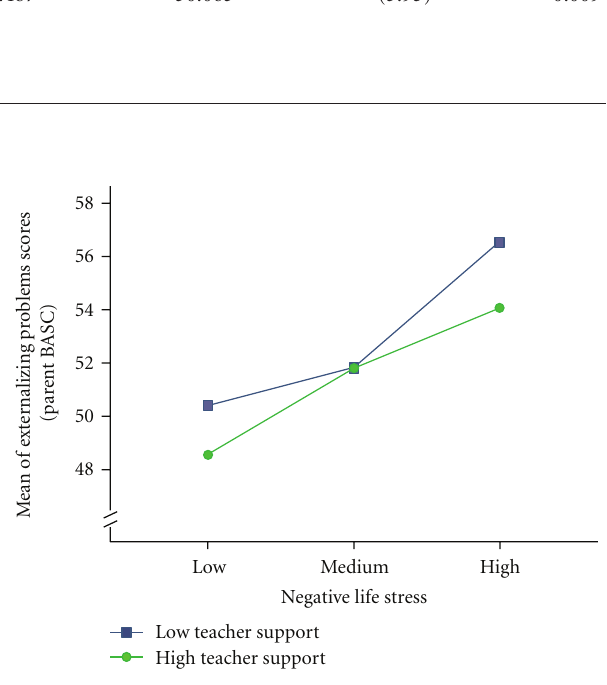
Figure 1: Mean externalizing problems composite scores on parent (BASC) as a function of the amount of teacher support and negative life stress